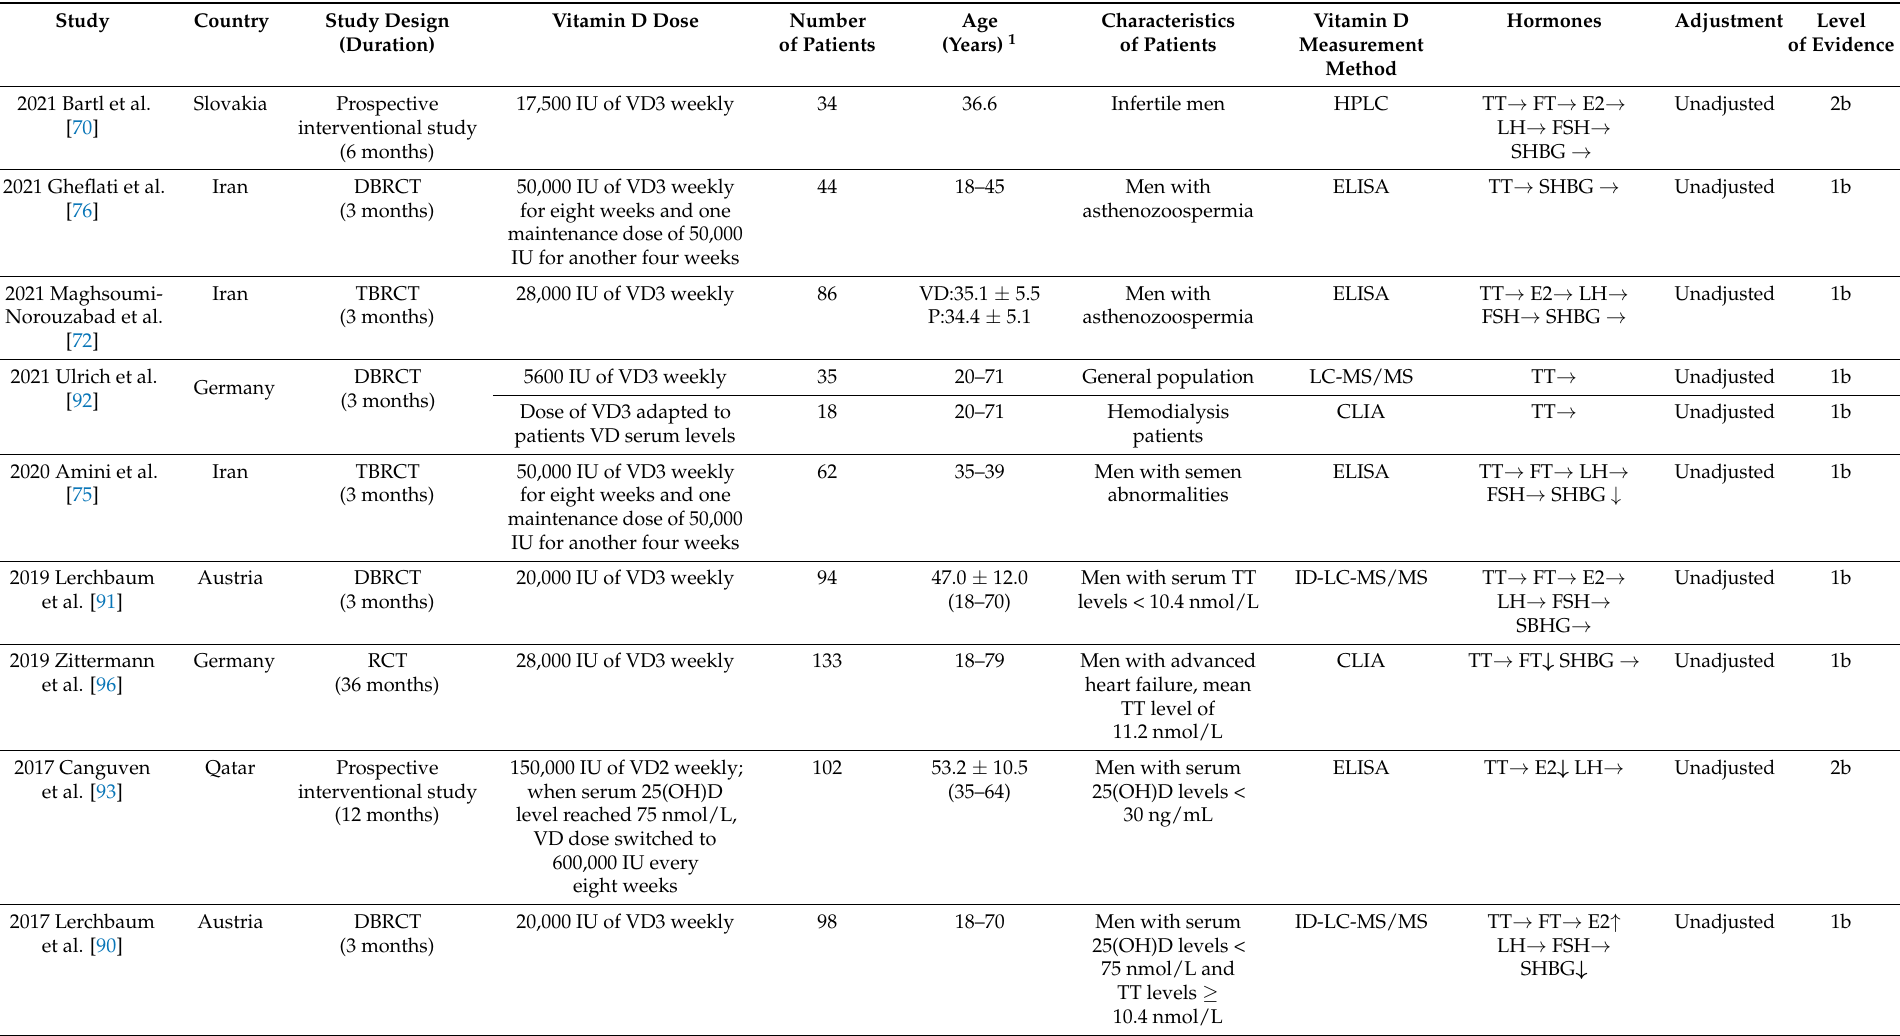
Table 4. Summary of Interventional Studies between Vitamin D and Sex Steroids in